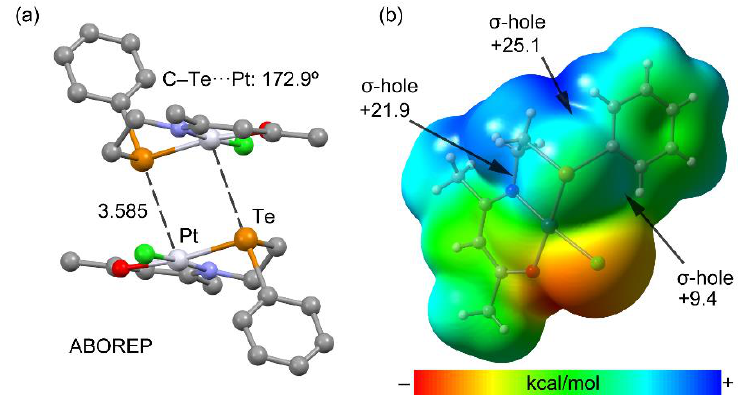
Figure 14. ( a ) Partial view of refcode ABOREP structure. Distances in Å . H-atoms omitted for clarity. ( b ) MEP surface (isodensity 0.001 a.u.) of ABOREP. The energies at the σ -holes are indicated in kcal/mol.